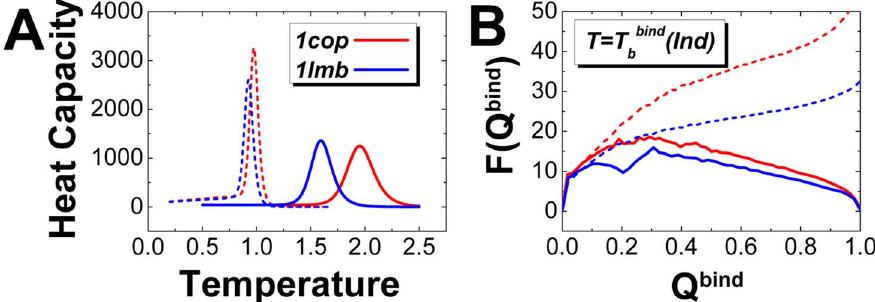
Figure 1. The binding affinity (stability) for rigid (independent) and flexible (effective) binding shown in (A) heat capacity curves and (B) free energy landscapes for Lambda Cro repressor (PDB: 1cop) and Lambda repressor (PDB: 1lmb). The solid and corresponding dotted lines represent rigid and flexible binding respectively. Free energy landscapes are plotted at the rigid binding transition temperatures, which are calculated from the peaks of heat capacity curves for binding, respectively. Free energy is in reduced unit. Q bind is the fraction of native interfacial binding contacts. "Ind" and "Eff" are the abbreviations for "Independent" and "Effective" binding, respectively.